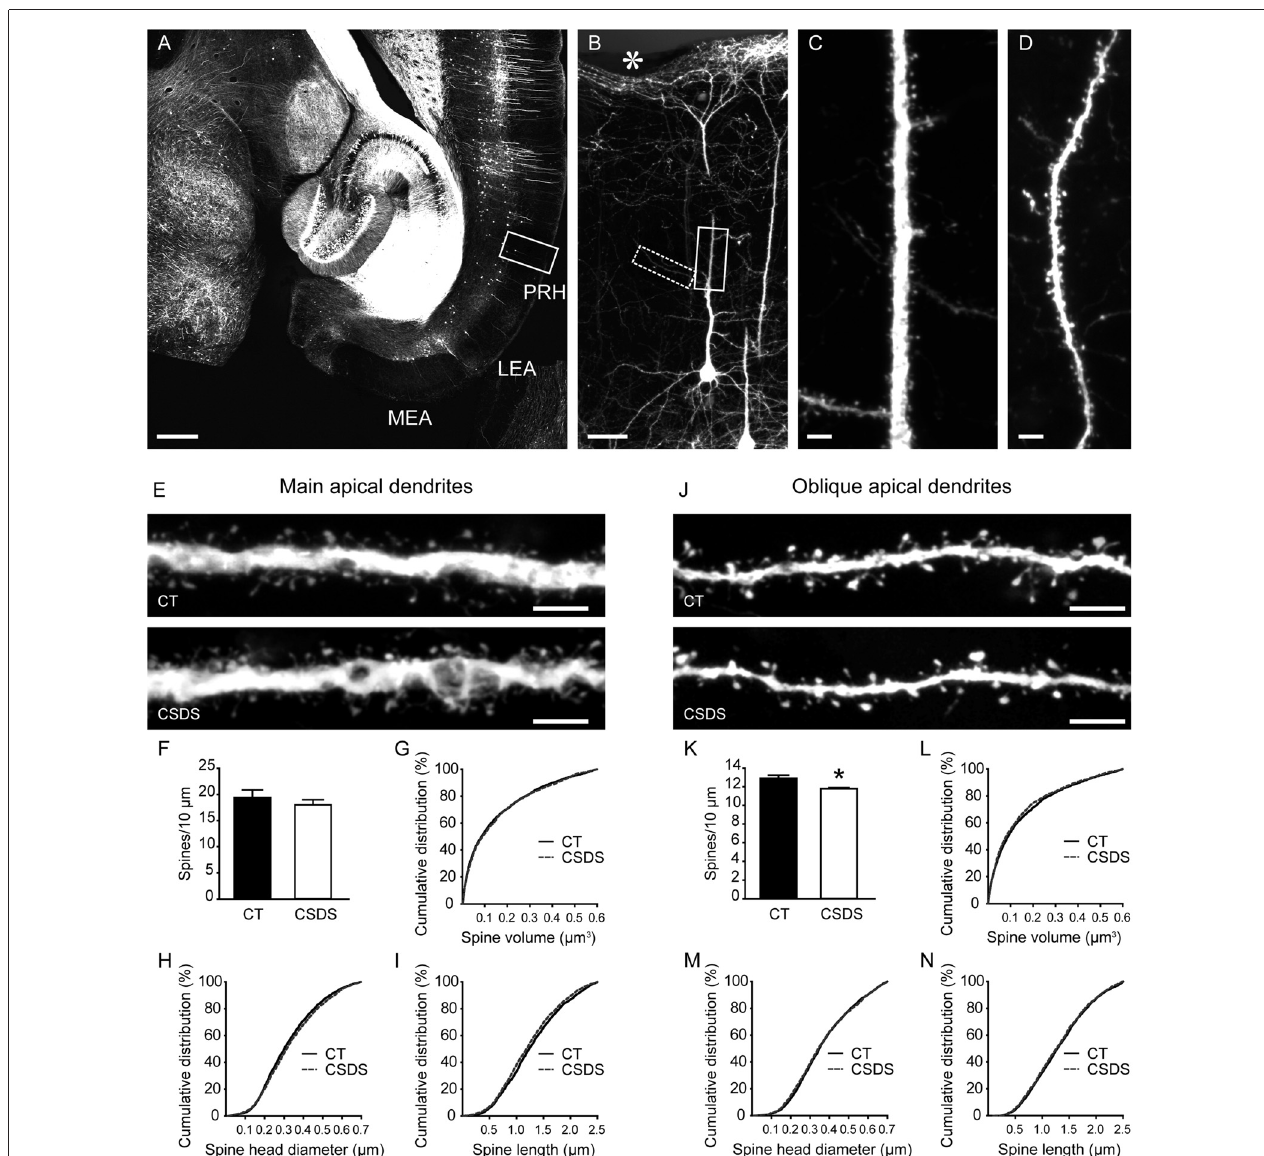
FIGURE 4 | Effects of CSDS on dendritic spine plasticity in perirhinal layer V pyramidal neurons. (A) A transverse section at the ventral hippocampal level from a Thy1-EYFP-H mouse. Note that in the medial entorhinal cortex (MEA) and the lateral entorhinal cortex (LEA), very few neurons are labeled by EYFP. PRH, perirhinal cortex. Scale bar = 500 µ m. (B) The magnified image of the insert in (A) showing EYFP-labeled layer V pyramidal neurons in the perirhinal cortex. The asterisk indicates the rhinal fissure. Scale bar = 50 µ m. (C) High-resolution projected raw z-stacks of the main apical dendrite in the insert (solid line) in (B) . Scale bar = 5 µ m. (D) High-resolution projected raw z-stacks of the oblique apical dendrite in the inset (dashed line) in (B) . Scale bar = 5 µ m. (E) Representative deconvolved and projected z-stacks showing the main apical dendrites in the control and defeat mice. Scale bars = 5 µ m. (F,G) In the main apical dendrites, spine density and spine volume were comparable between groups. (H,I) CSDS increased spine head diameter but reduced spine length. (J) Representative deconvolved and projected z-stacks showing the oblique apical dendrites in the control and defeat mice. Scale bars = 5 µ m. (K) CSDS reduced spine density in the oblique apical dendrites of perirhinal layer V pyramidal neurons. (L–N) Spine volume, spine head diameter and spine length were similar between groups. ∗ p < 0.05 vs. the control group. n = 4 mice per